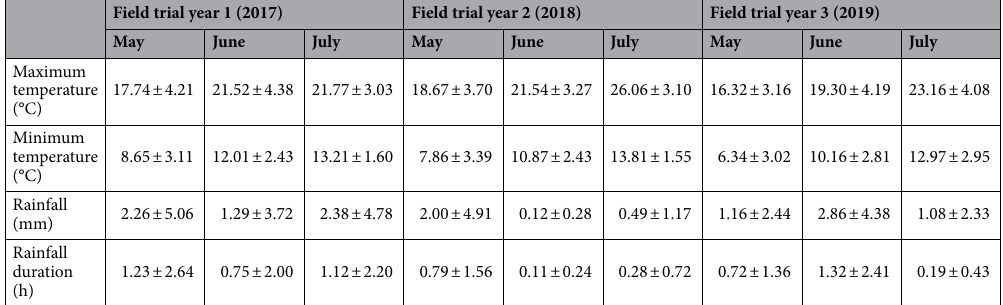
Table 1. Average maximum temperature, minimum temperature, amount of rainfall and rainfall duration ± SD for May, June, and July during field trial year 1 (2017), 2 (2018) and 3 (2019) at Rothamsted Research, Harpenden, Hertfordshire,